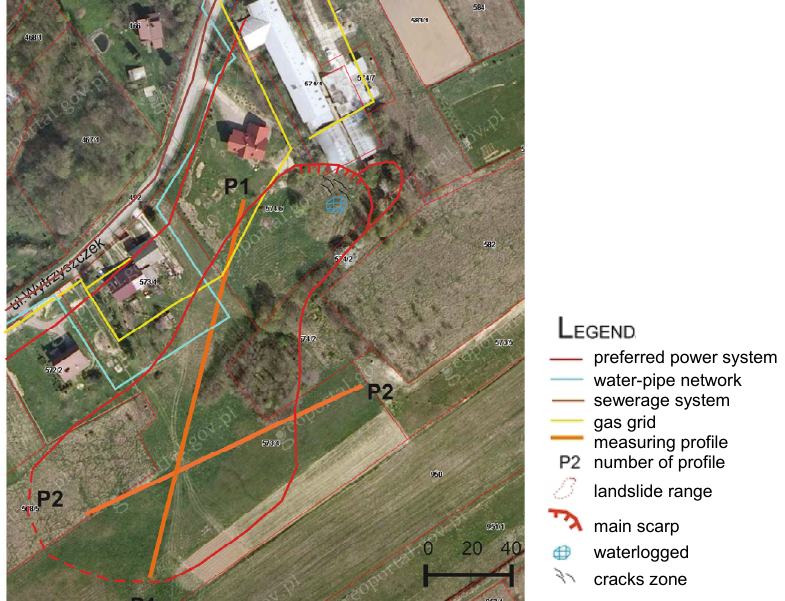
Fig. 2. Arrangement of the underground infrastructure within the borders and areas adjoining the landslide and GPR